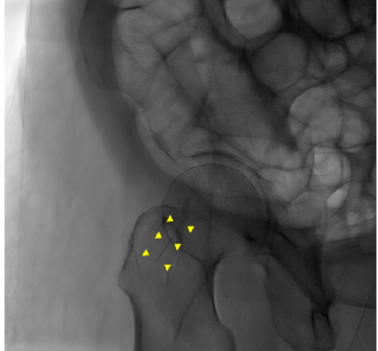
Figure 2. Fluoroscopic radiography of pelvic bone. A needle fragment showed in the right groin (yellow triangles).